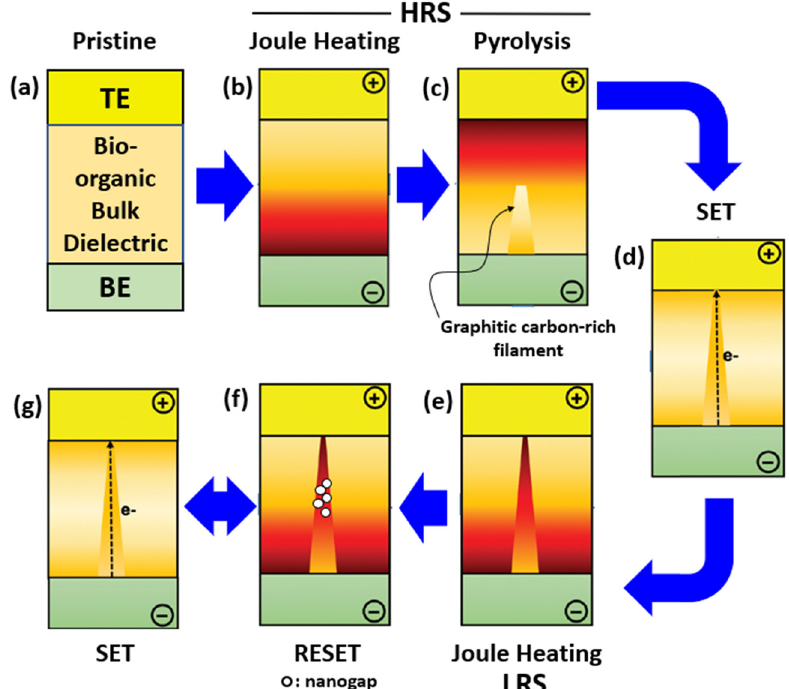
Figure 19: A series of schematics illustrating the thermochemical process of resistive switching. ( a ) Pristine state, ( b ) Joule heating at HRS, ( c ) pyrolysis, ( d ) set state with conductive fi lament formed, ( e ) Joule heating at LRS, ( f ) reset state with breakage of conductive fi lament, and ( g ) reversible to the set state. The fi gure is modi fi ed from ref. [ 18 ]